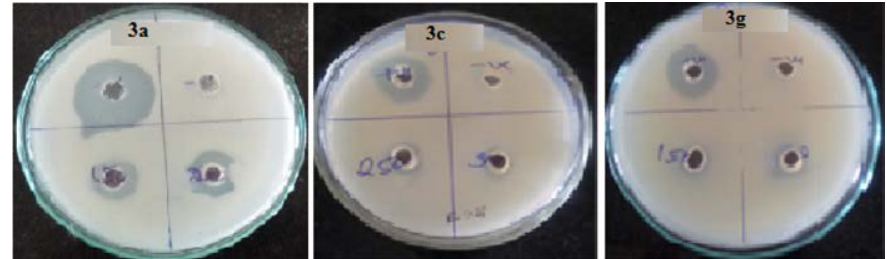
Figure 7. Photographs showing antibacterial activity of the formamides (3a, 3c and 3g) in agar well diffusion method with Gram -ve Escherichia coli bacteria. Table 2. Antibacterial activity of standard and samples employing E.